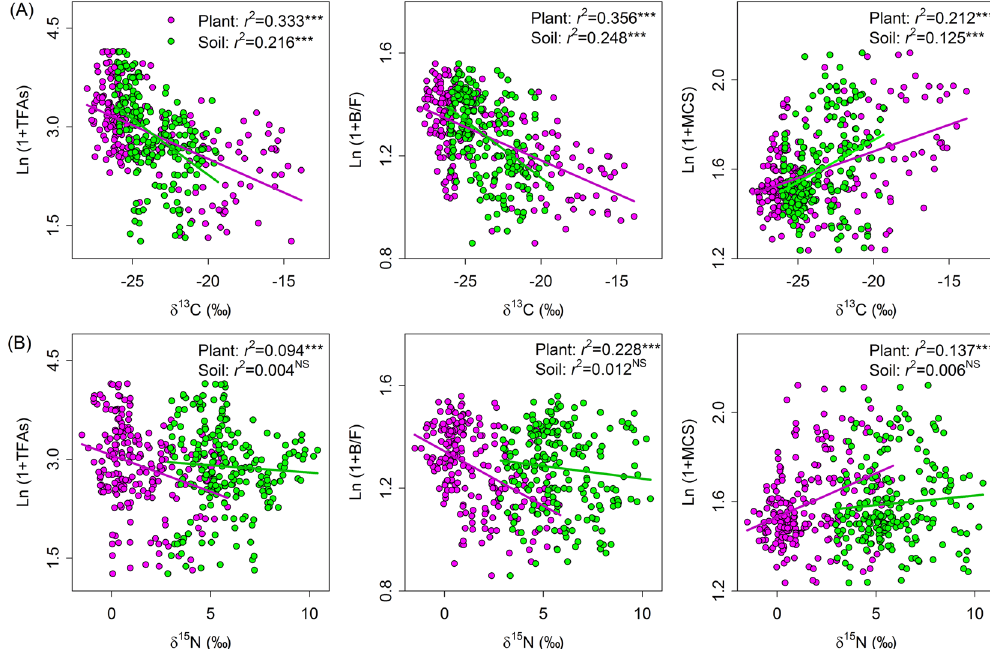
Figure 2. Relationships between microbial community variables and ( A ) δ 13 C isotopic values and ( B ) δ 15 N isotopic values of plants (pink symbols) and soils (green symbols) at the regional scale in the Mongolian grassland. Abbreviations are explained in Table 1. Regression analysis is indicated by r 2 and significance level (NS, P > 0.05; ** P < 0.01; *** P <